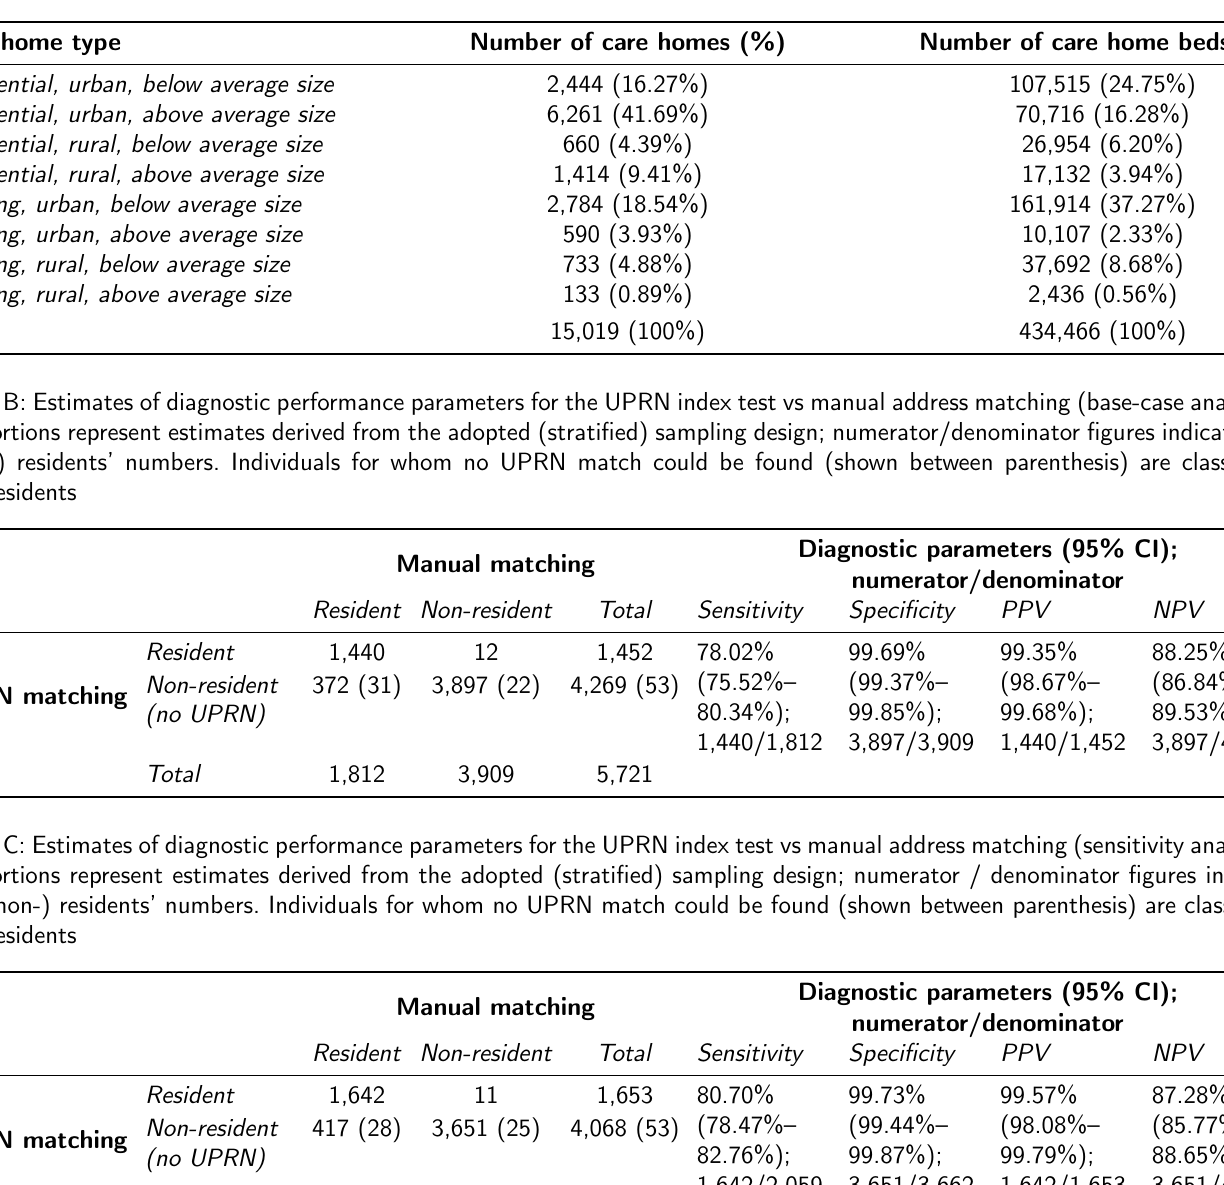
Table A: Number (%) of care homes and respective bed stock in England as of February 2020 (source: CQC)